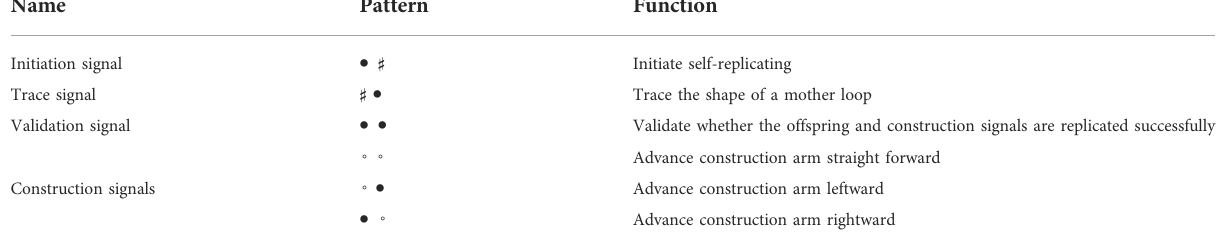
TABLE 1 The list of functions about various